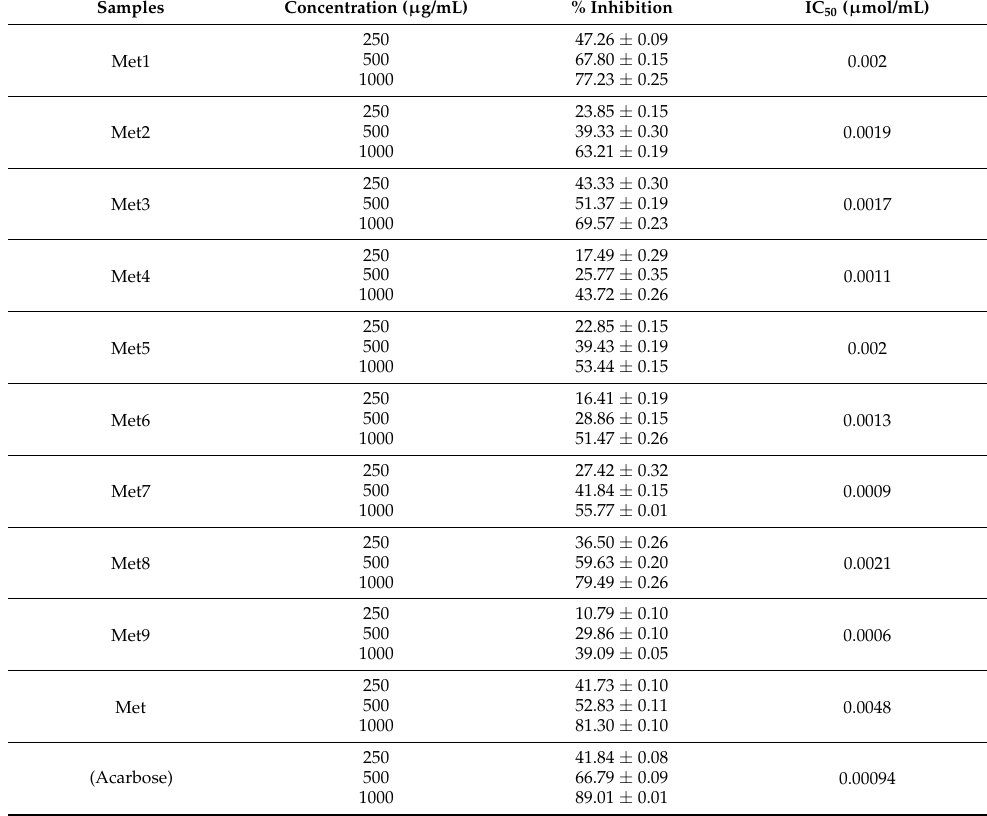
Table 4. α -Glucosidase activity of